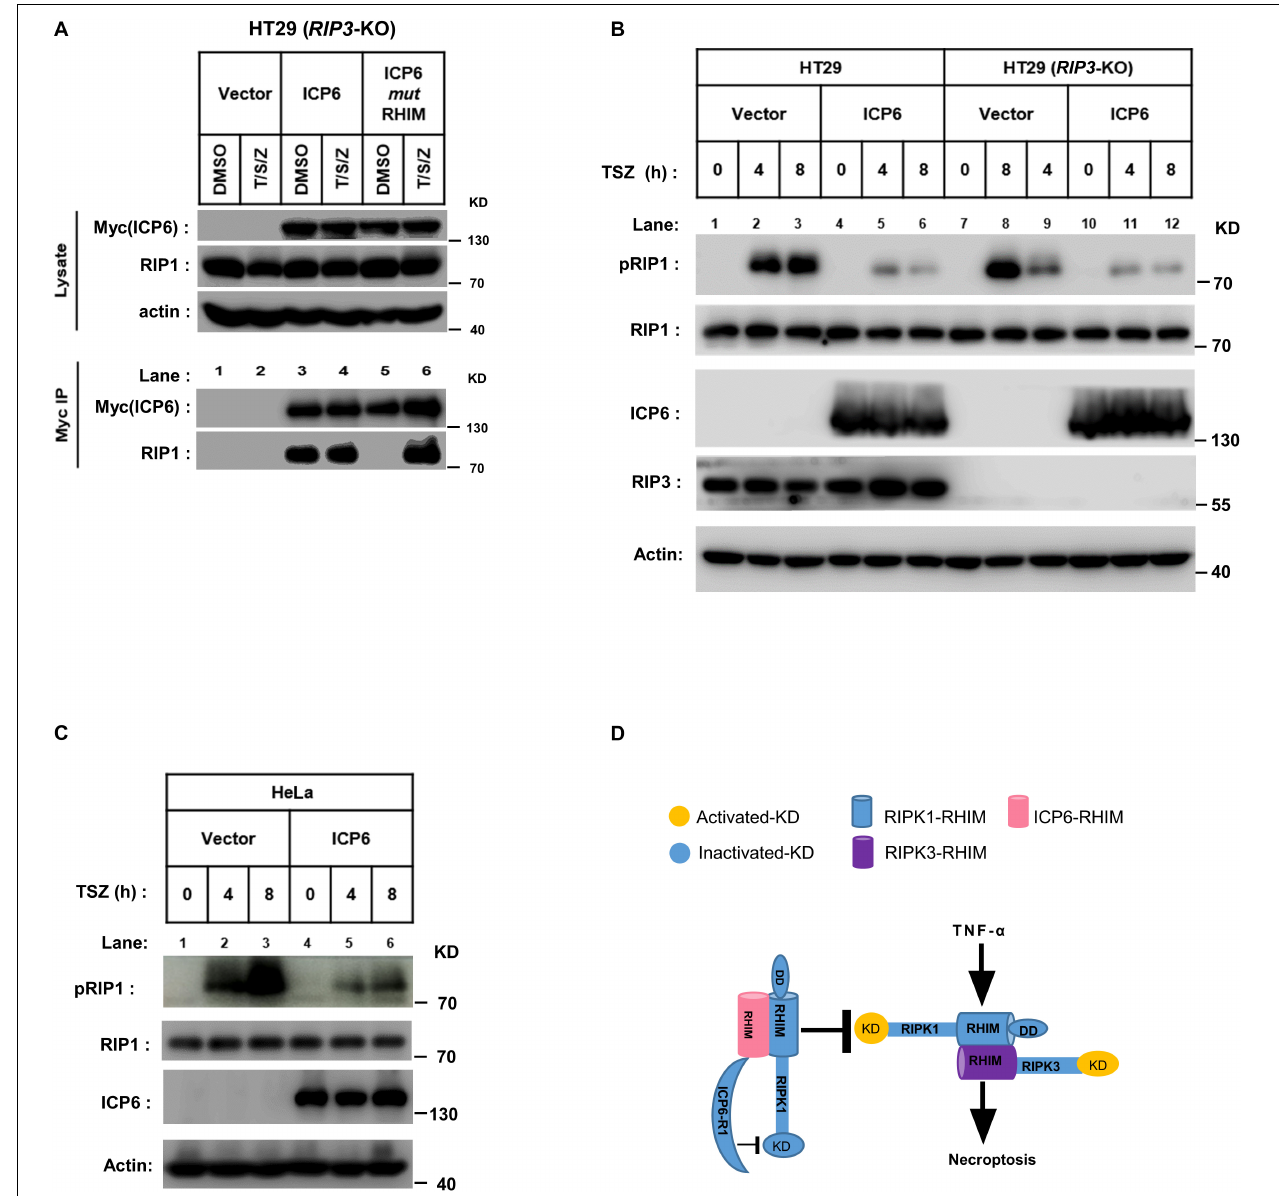
FIGURE 5 | The inhibition of RIP1 auto-phosphorylation by ICP6 is RIP3 -independent. (A) HT29 ( RIP3 -KO) cells were infected with empty virus (Vector) or lentiviral virus encoding Myc-tagged ICP6. Then these cells were treated with T/S/Z for 6 h. Whole-cell lysates were subjected to immunoprecipitation with anti-Myc. The total cell lysates and immunoprecipitates were analyzed by western blot with the indicated antibodies. (B,C) ICP6 reduces the phosphorylation of RIP1. HT29, HT29 ( RIP3 -KO) (B) and HeLa (C) cells with indicated lentivirus infection were treated with T/S/Z for indicated time. The cells were then harvested, and the whole-cell extracts were analyzed by western blotting to check the RIP1 activation with anti-phospho-hRIP1 (S166). β -Actin and total RIP1 were shown as loading control. (D) The proposed mechanism of ICP6 inhibited necroptosis. KD, kinase domain; RHIM, RIP homotypic interaction motifs; DD, death domain; R1, C-terminal R1 homology domain of ICP6. Cells with necroptosis induction (TNF) undergo RIP1- RIP3 interaction and kinase activation which are indispensable for necrosome maturation and cell necroptosis. ICP6 block necroptosis through ICP6-RIP1/3 RHIM domain interaction, then the ICP6-R1 could block RIP1 kinase activation to necrosome